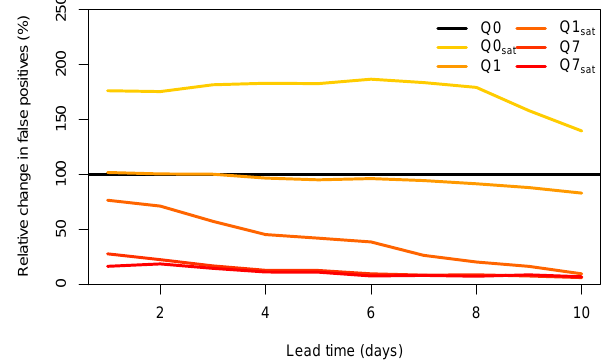
Figure 9. Relative changes in false positive flood alerts for the 90th percentile threshold, compared to the no-assimilation scenario ( Q 0) for different forecasting times. A total of 1035 time steps with flooding were observed for the Upper